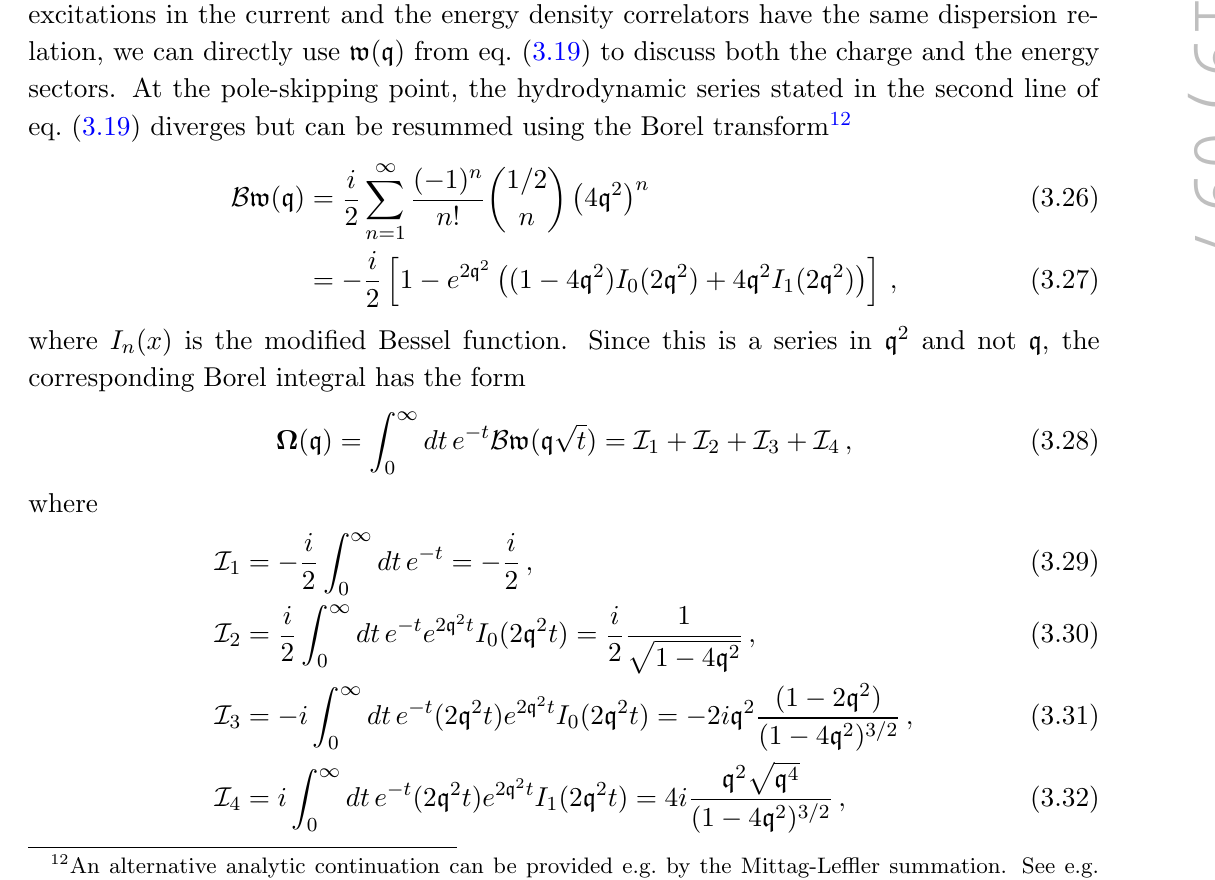
Figure 5 . The approximations to the exact position of the critical point j q 2 graphic model with broken translation symmetry determined from the hydrodynamic algebraic curves F k ( q 2 ; w ) = 0 as a function of k